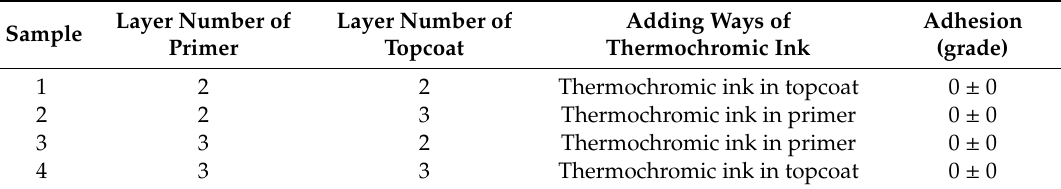
Table 8. Orthogonal experimental result of the influence of the coating process on the adhesion of coating.